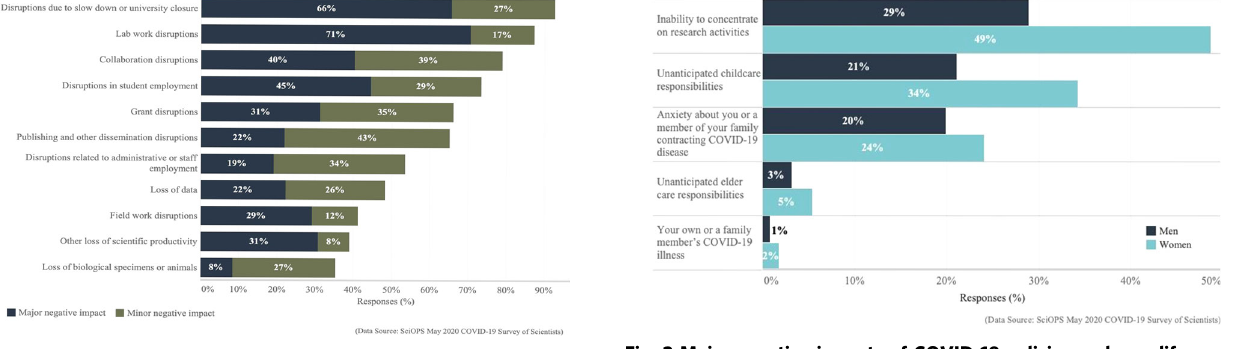
Fig. 2 Major negative impacts of COVID-19 policies on home-life situations of scientists, by gender. This chart summarizes the weighted proportions of female (light blue) and male (dark blue) scientists (on the x - axis; ranging from 0% to 50%) who identi fi ed negative impacts of social distancing and other COVID-19 policies (listed on the y -axis) on their research activities as a consequence of their home-life situations. (Exact question wording: “ Have social distancing and other COVID-19-related policies had a negative impact on your research vis-à-vis any of the following home-life situations? ” ).